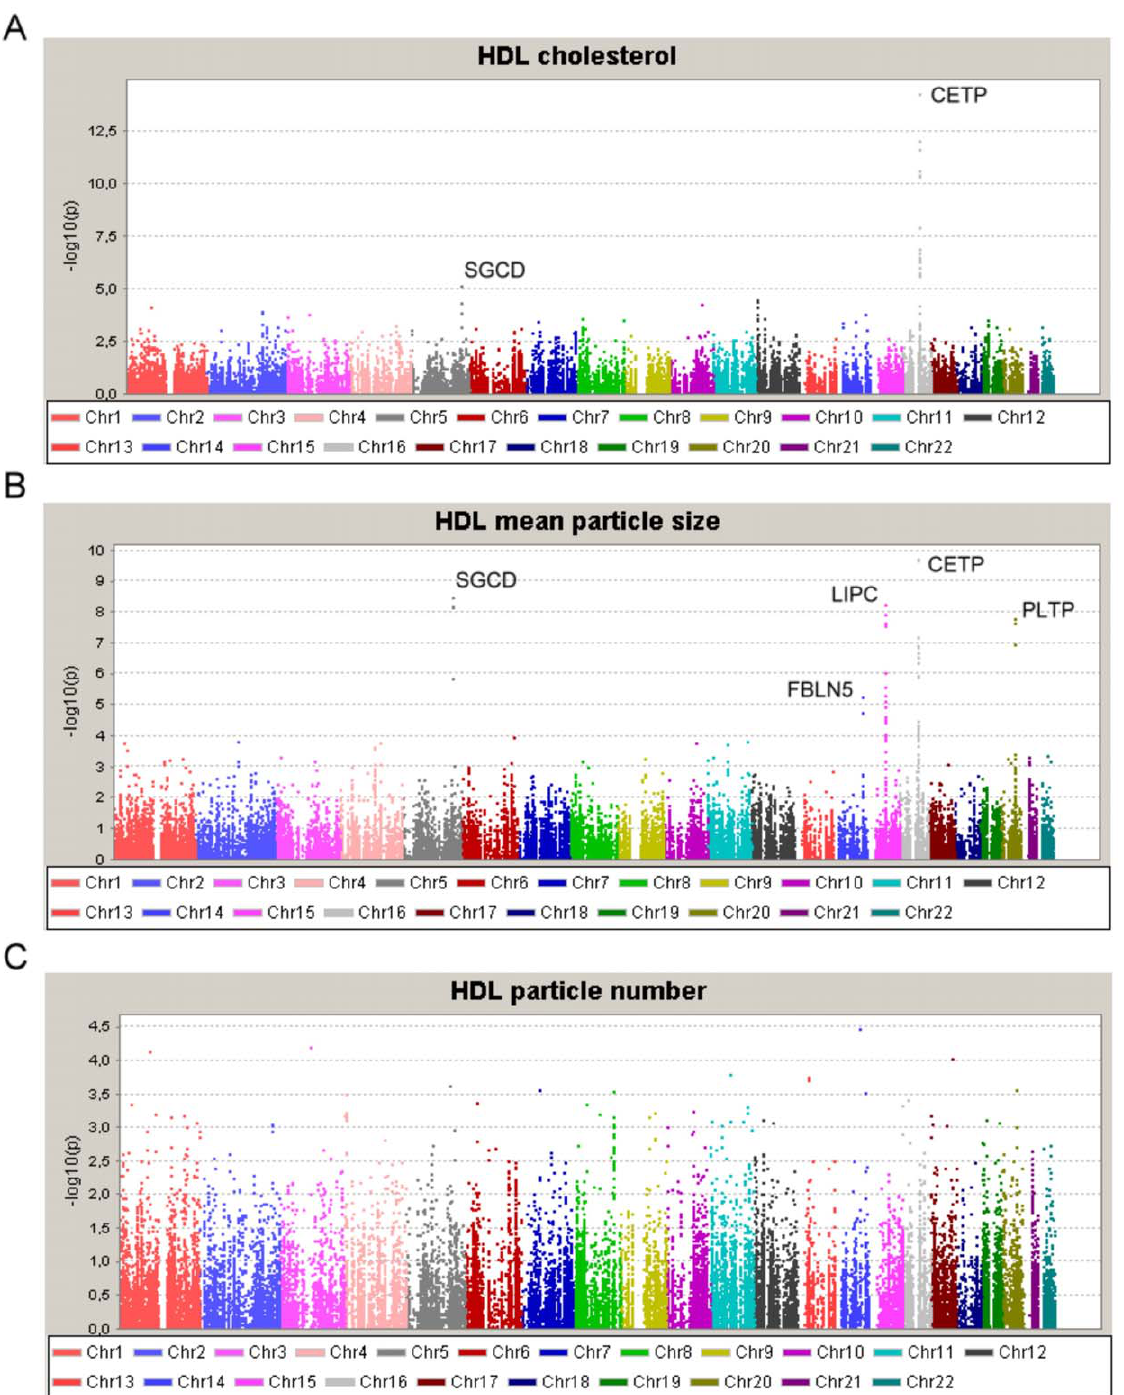
Figure 1. Summary of association results for HDL-C, HDL particle size and HDL particle number. Data are –log transformed p-values from association analyses for all SNPs plotted against their chromosomal location, for enzymatically determined HDL-C (panel A), NMR-derived mean HDL particle size (panel B) and NMR-derived HDL particle number (panel C). All signals with experiment-wide significance are labelled.